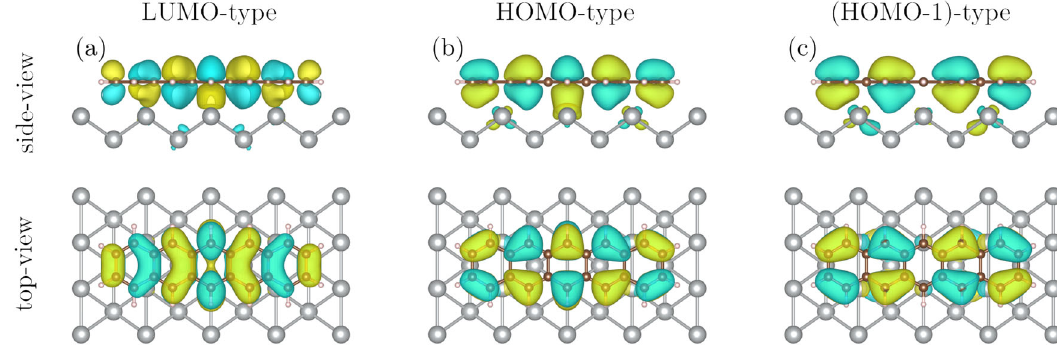
Fig. 3 Calculated orbitals of pentacene on the Ag(110) cluster. Orbitals with a major contribution of ( a ) LUMO-, ( b ) HOMO-, and ( c ) (HOMO-1)-type character. The orbitals do not noticeably change with the increase of the cluster size in any direction. The orbitals are visualized using the VESTA software 49 enables resolving the time-dependent PMMs down to the femto- second scale, as depicted in Fig. 4(a) for the photoemission signal of LUMO 1st , HOMO 1st , HOMO 2nd at E B = 0.2 eV, E B = 1.2 eV, and E B = 1.8 eV binding energy, respectively. The PMMs have been integrated over 350 fs with the center at the indicated pump- probe delay τ Delay and are smoothed in momentum space with a Gaussian fi lter with a FWHM of 0.16 Å − 1 . As already apparent